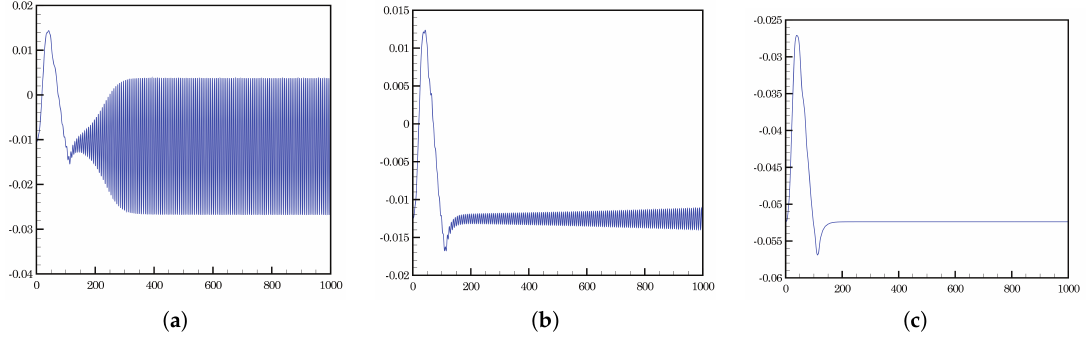
Figure 12. Normalized wing tip position along b 3 vs. normalized time for engine placement at ( a ) x 1 / l = 0.25 and x 2 / b = 0; ( b ) x 1 / l = 0.50 and x 2 / b = 0; ( c ) x 1 / l = 0.75 and x 2 / b = 1 [29].